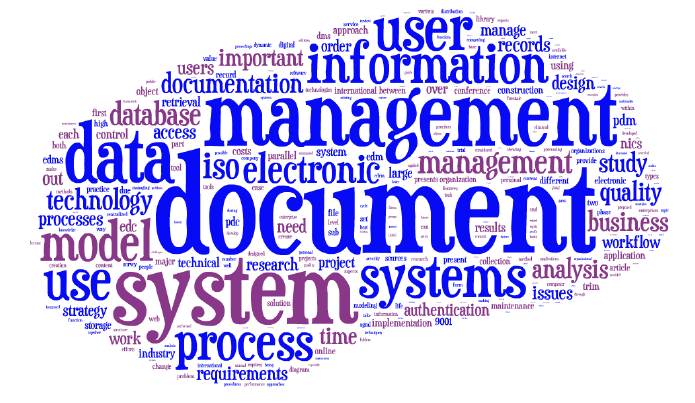
Figure 1 – Academic understanding of document